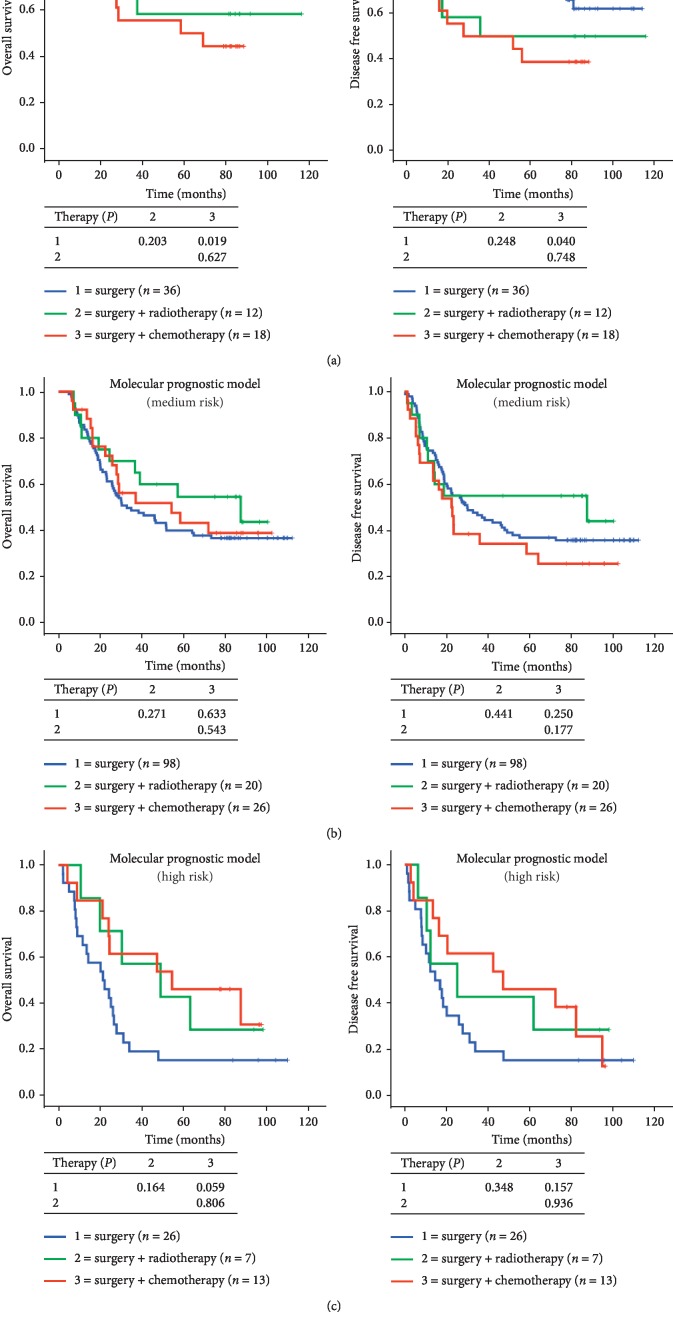
K-M survival curves indicate that radiotherapy and chemotherapy prolonged patients' OS and DFS in high-risk group but shortened patients' survival in low-risk group.